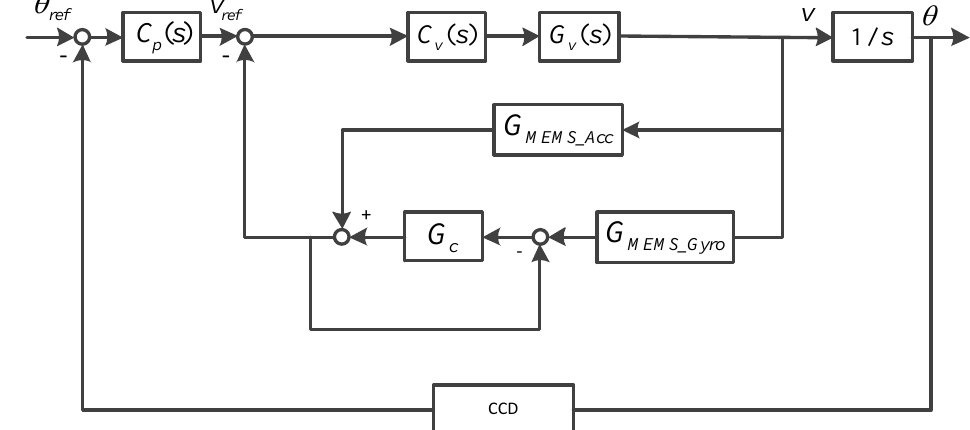
Figure 14. The control structure of OTT.